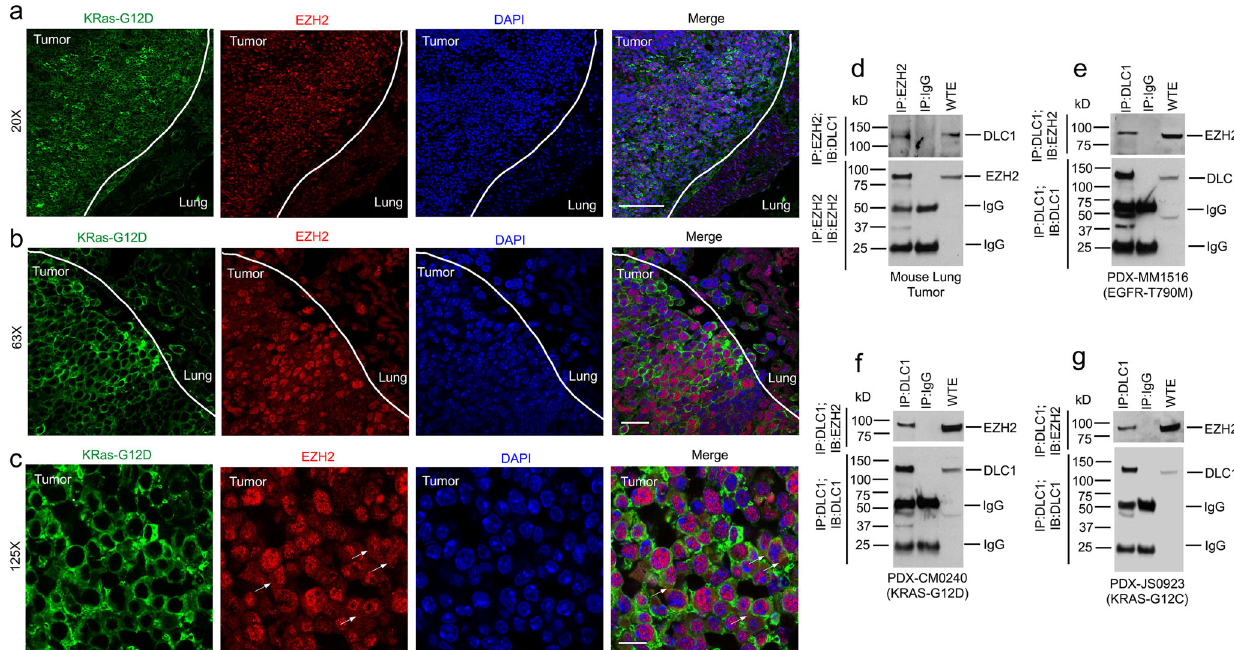
Fig. 7 NSCLC models have cytoplasmic EZH2 and form a complex with DLC1. a – c Sections from conditional KRAS -G12D mouse lung tumors were immunostained with KRAS -G12D (green), EZH2 (red) antibodies, and DAPI (blue) for nuclei. Tumors in the conditional KRAS -G12D mouse lung expressed higher levels of EZH2 protein than the adjacent non-tumor lung tissue, and EZH2 (red) is present in the cytoplasm as indicated by arrows in c . Scale bar, 100 µ m for a , 20 µ m for b , 10 µ m for c . d Complex formation between DLC1 and EZH2 in mouse lung tumors. Tumor extracts from conditional KRAS -G12D were IP with EZH2 or mock IgG antibodies followed by IB with DLC1 (top) or EZH2 (bottom) antibodies. WTE, whole tumor extract. e – g Complex formation between DLC1 and EZH2 in PDXs with mutant EGFR or mutant KRAS . Tumor extracts from PDXs with mutant EGFR-T790M ( e ), mutant KRAS- G12D ( f ), mutant KRAS-G12C ( g ) were IP with DLC1, or mock IgG antibodies followed by IB with EZH2 (top) or DLC1 (bottom) antibodies. WTE, whole tumor extract. Two independent experiments were performed for a – g with similar results. Source data are provided as a Source Data fi